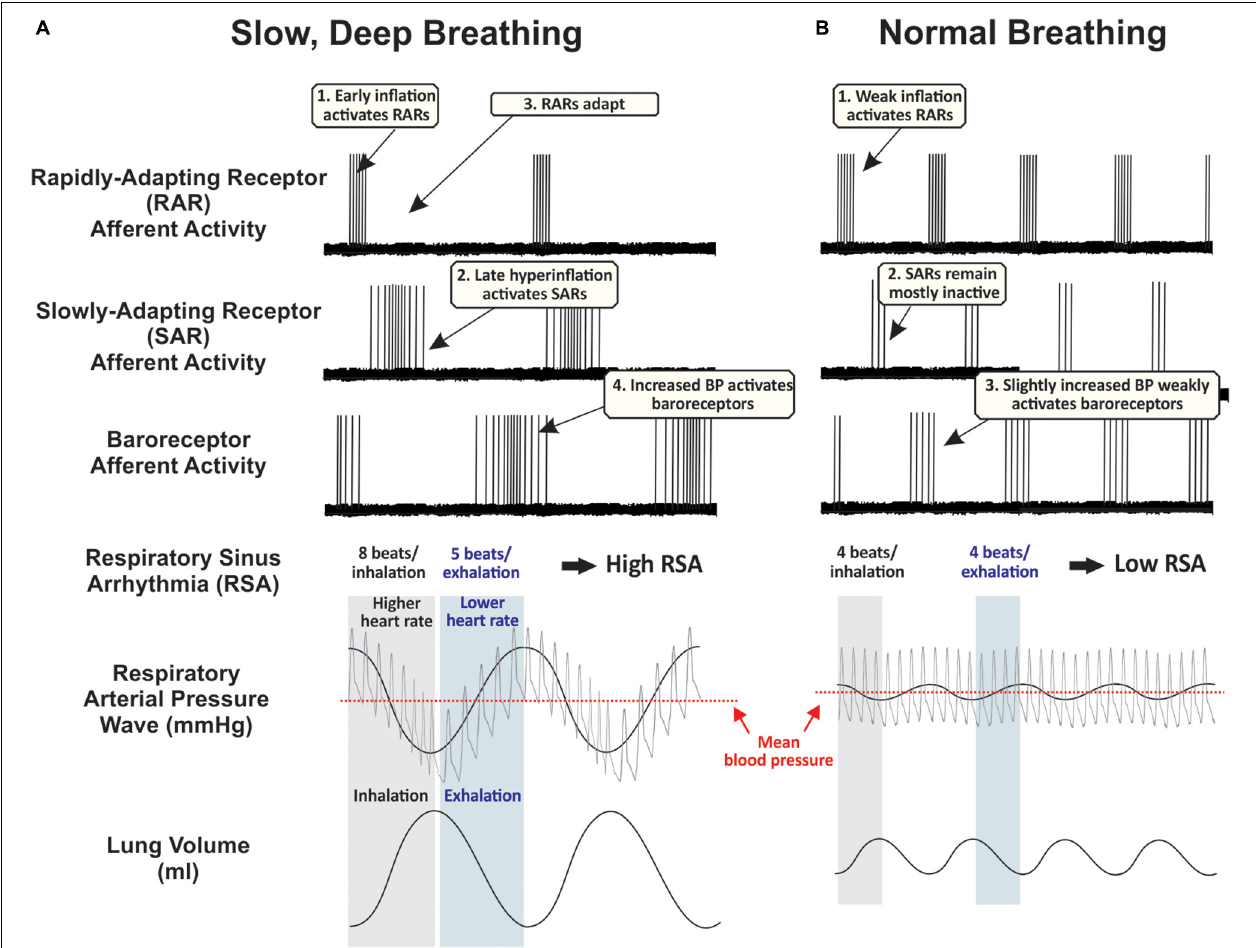
FIGURE 1 | Proposed time course of peripheral afferent effects during (A) slow, deep breaths, and (B) normal breaths. These hypothetical traces are partly based on records from supportive experiments in anesthetized rats (Ho et al., 2001; Schelegle, 2003). During normal breathing, rapidly-adapting receptors (RARs) are phasically active during inspiration, slowly-adapting receptors (SARs) remain mostly inactive, and baroreceptors are weakly activated during exhalation. During repetitive deep breathing, RARs are activated during the early component of inhalation and then lungs hyperinflate at sufficient pressures to activate low- and high-threshold SARs, increasing traffic through the vagus nerve. Deep exhalations amplify respiratory arterial pressure waves to strongly activate peripheral baroreceptors. Human carotid baroreceptors are slowly-adapting (Eckberg, 1977). Along with these cardiorespiratory vagal afferents, additional airway afferents probably play a significant role in mediating the sensory element of slow, deep breathing, while sensory and motor systems are highly integrated to control the rate of airflow from the lungs and implement cognitive control of respiratory motor drive (see Introduction). BP, blood